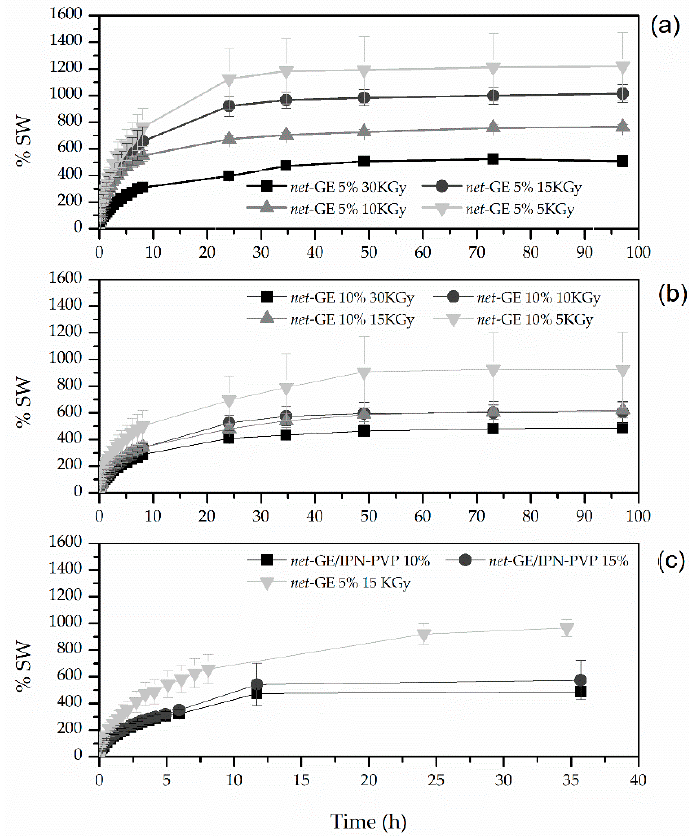
Figure 5. Swelling of net -GE synthesized with different GE concentrations: ( a ) 5% and ( b ) 10% in distilled water at room temperature ( c ).